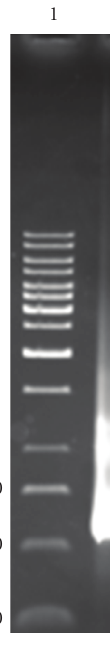
Figure 2: PCR assembly of FGF1 . Lane 1: DNA molecular weight markers. Lane 2: Assembled and amplified FGF1 gene (520bp).